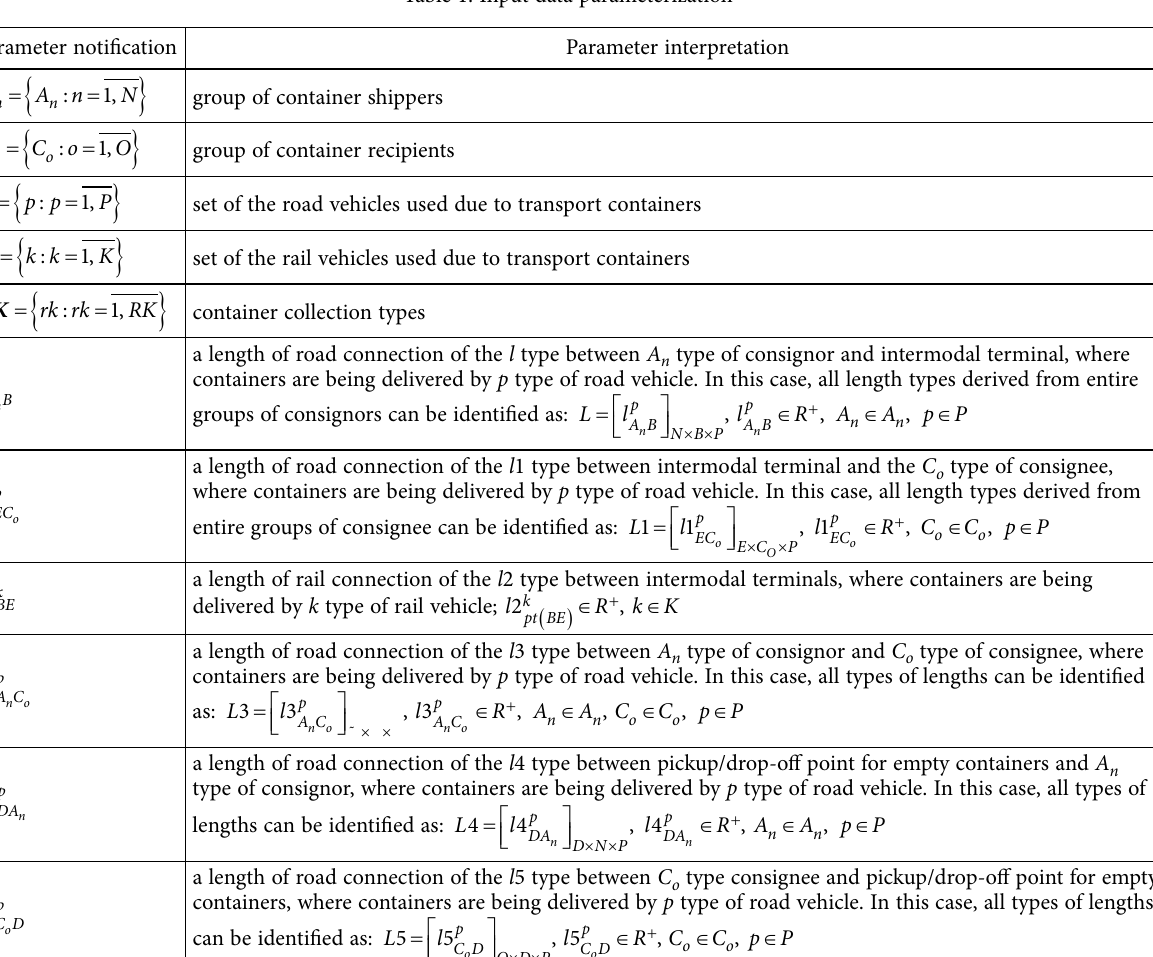
Table 1. Input data